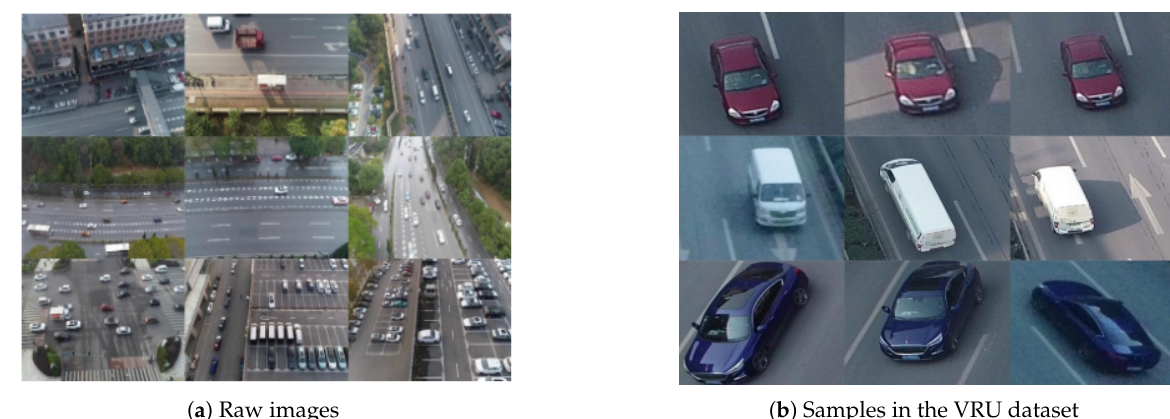
Figure 4. The comparison of raw images and pictures in the VRU